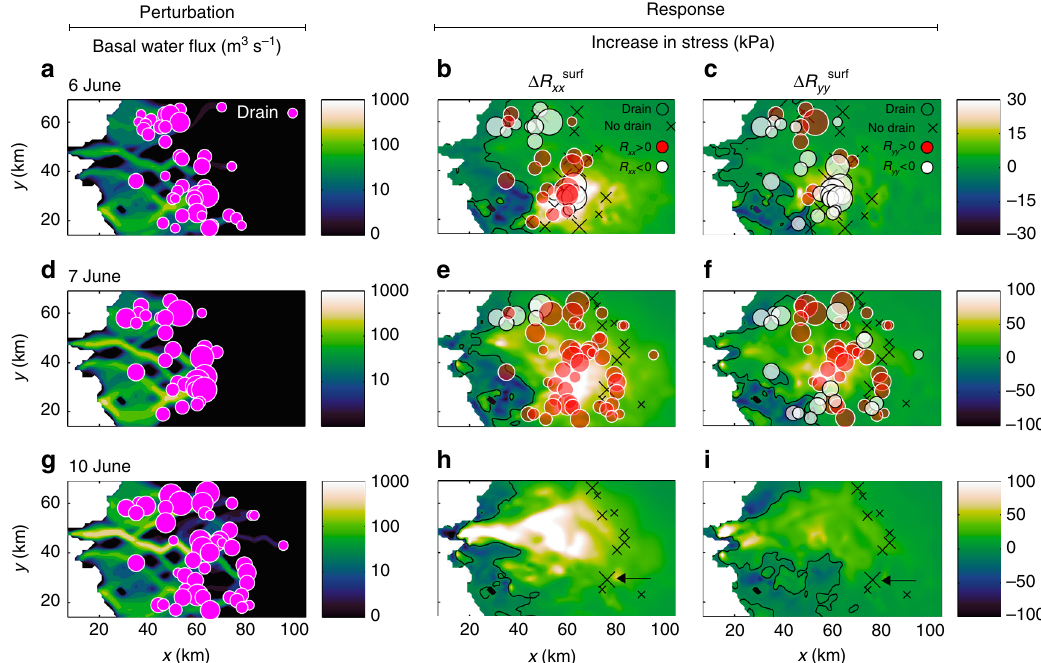
Fig. 4 Dynamic triggering of cascading lake drainage. a Enhanced fl ux in the subglacial drainage system caused by 43 lakes observed to drain on 6 June. b Change in resistive stress in the x direction ( Δ R surf xx , kPa) on 6 June relative to the day before. Dots show 30 additional lakes observed to drain the next day (7 June). The colour of dots denotes lakes that drained where ice fl ow in the x direction was extensional ( R surf xx > 0, red dots) or compressional ( R surf xx < 0, white dots) before the 30 additional lakes drained. The locations of 16 lakes that had formed but did not drain that day are marked with black crosses. c Same as b but showing change in resistive stress in the y direction ( Δ R surf yy , kPa). Note how 20 of the 30 lakes drained where ice fl ow was extensional in either the x direction or the y direction or in both directions before drainage occurred. The magnitudes of R surf xx and R surf yy are shown in Fig. 3. d Basal water fl ux from the 30 lakes that drained on June 7. e Δ R surf xx associated with the lakes that drained on 7 June. Dots show additional 51 lakes which drained by 10 June (incl. 8 – 9 June when clouds prevented lake observation). f Same as e but showing Δ R surf yy . Note how 47 of the 51 lakes drained where ice fl ow was extensional in at least one direction before drainage occurred. g Basal water fl ux from the 51 lakes that drained during 8 – 10 June. h Δ R surf xx associated with lakes draining 8 – 10 June. Crosses mark 10 lakes that remained unaffected by the tensile shock and did not drain. Arrow identi fi es the only lake to persist from 6 June to 10 June. i Same as h but showing Δ R surf yy . Note how drainages increasingly occur when ice fl ow has switched from compressional to extensional and how the location of unchanged lakes on 10 June falls outside the region of the tensile